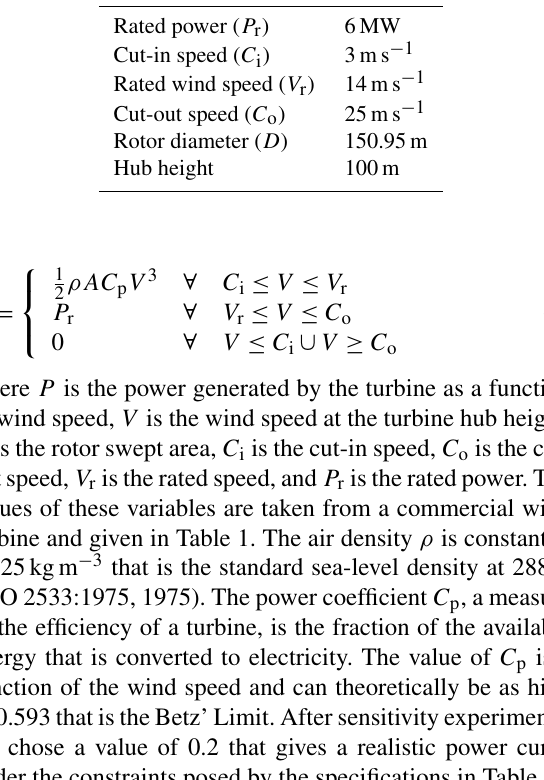
Table 1. Specifications of the wind turbine used in this study. Turbine